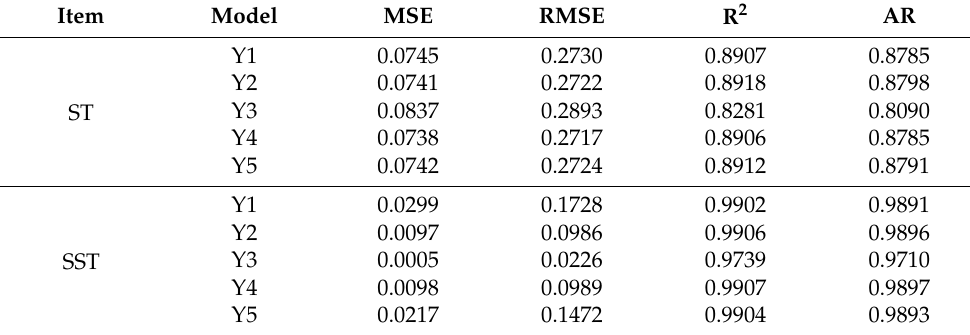
Table 7. Validation evaluation of the temperature construction